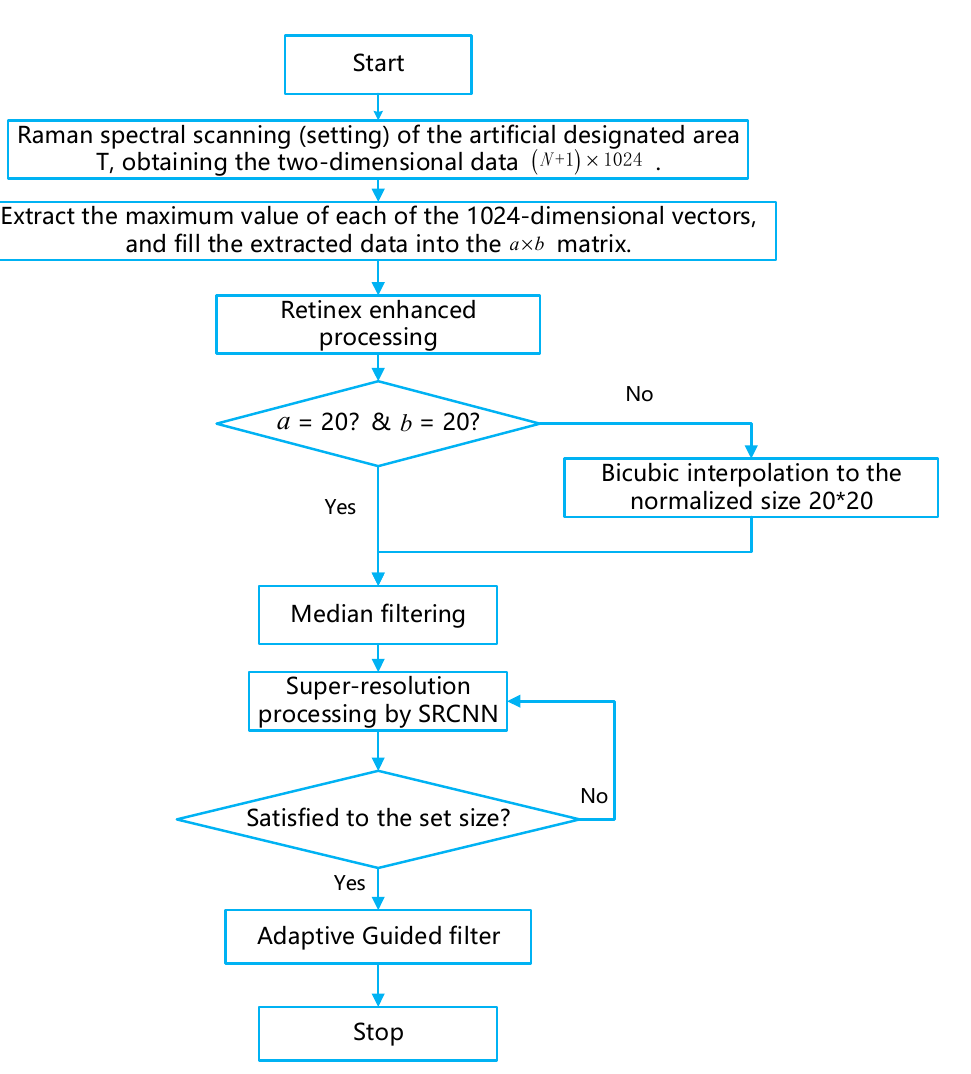
Figure 15. The flow chart of this paper’s algorithm.